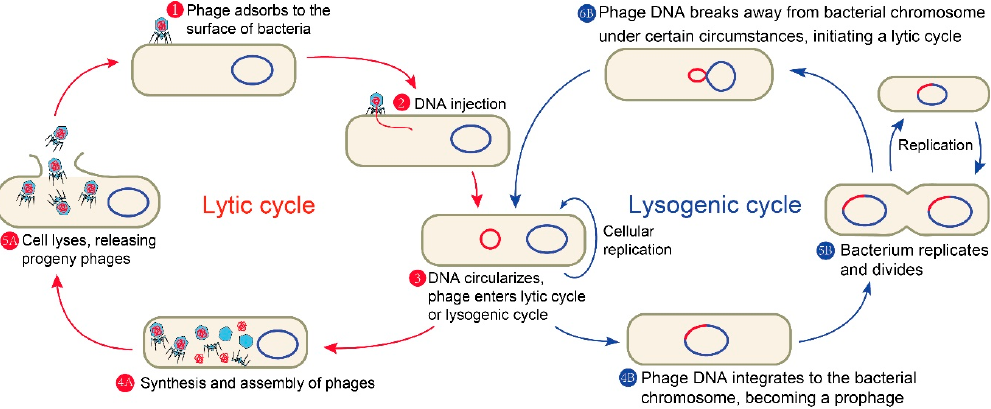
Figure 1. A complete phage life cycle of the common tailed phage.